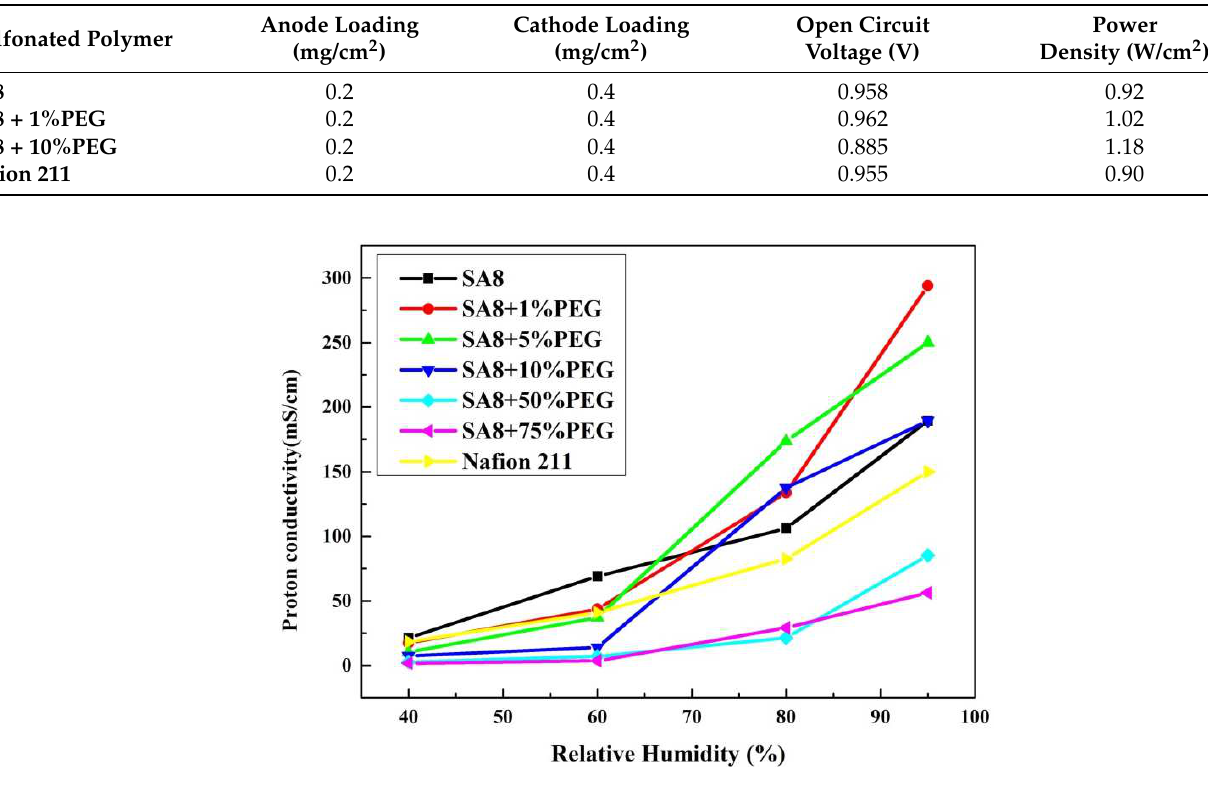
Figure 18. The proton conductivity diagram of SA8 blended with PEG.